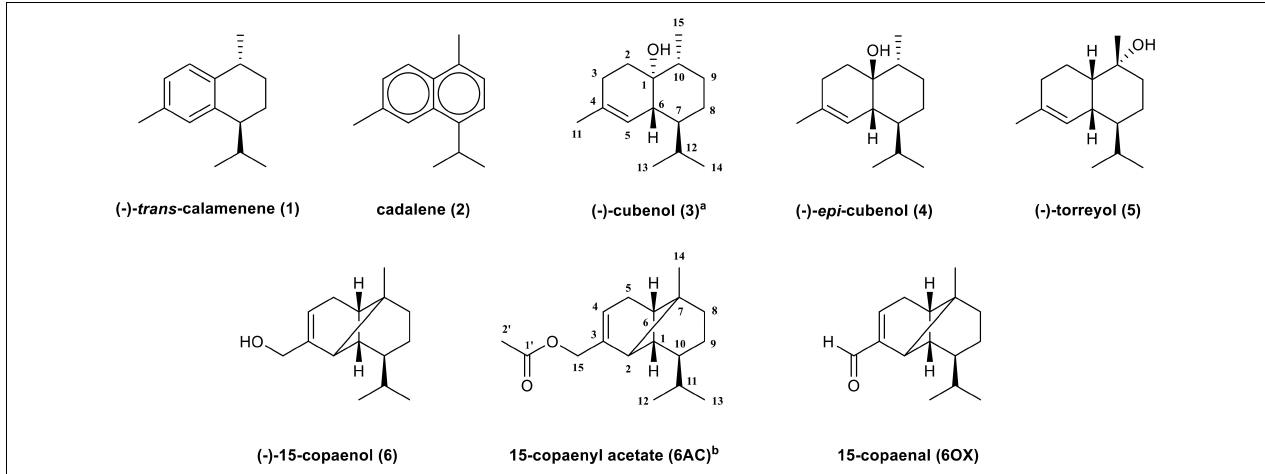
FIGURE 1 | Sesquiterpenes isolated from Pilgerodendron uviferum and synthetic derivates of 15-copaenol. a Numbering belongs to compounds 1–5. b Numbering belongs to 15-copaenol, 6AC, and